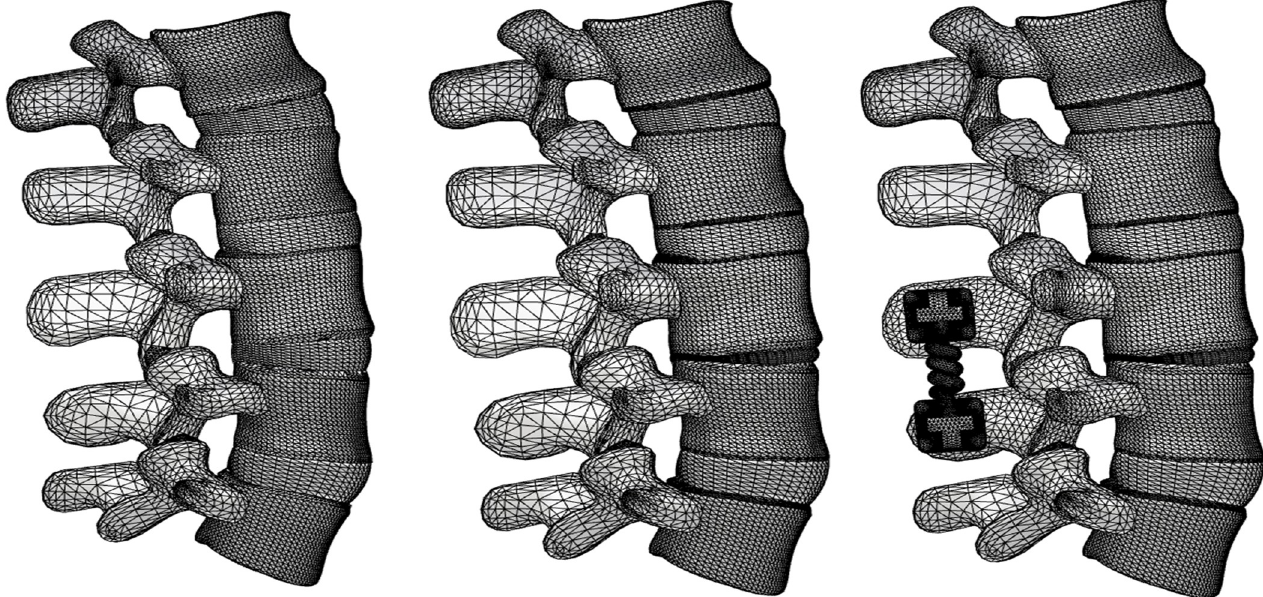
Fig 1. Finite element models of (a) healthy lumbar spine, (b) degenerative lumbar spine with degenerative disc disease, and (c) lumbar spine inserted by the lumbar interspinous fixation device (LIFD). https://doi.org/10.1371/journal.pone.0265926.g001 The intervertebral discs between the lumbar spine segments were created with nucleus pul- posus, ground substance and annulus fibrosis. The ground substance was modeled as a six- layer, and annulus fibrosis was modeled to surround each layer of ground substance. An eight- node hexahedral element (C3D8H) with a Mooney–Rivlin hyperelastic material property was used as the ground substance. The fluid cavity was formed using a four-node tetrahedral fluid element (SFM3D4) to simulate the fluid behavior of the nucleus pulposus. The annulus fibrosis was modeled as a two-node truss element (T3D2) that resists only tension, and its stiffness increases as the distance from the nucleus pulposus increases [35–37]. The seven types of lumbar ligaments—anterior longitudinal, posterior longitudinal, trans- verse, interspinous, supraspinous, facet joint capsule, and flavum ligaments—were modeled to be attached to the lumbar spine based on anatomical information. These ligaments were also modeled as a tension-only two-node truss element (T3D2), similar to annulus fibrosis (Table 1) [38,39].